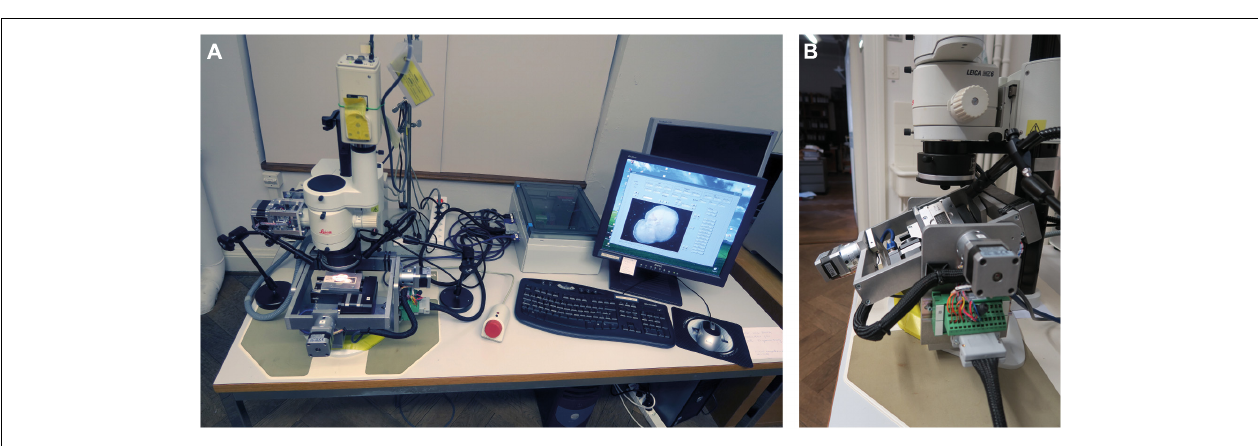
FIGURE 3 | The new System AMOR 2. (A) Motorized microscope and stage, stepping box (white) with the electronics, and human interface devices. The PC stands under the table. (B) Close up of the motorized stage in forward Roll position (outer frame) and Pitch position to the right (inner frame). The stage can be unplugged from the stepping